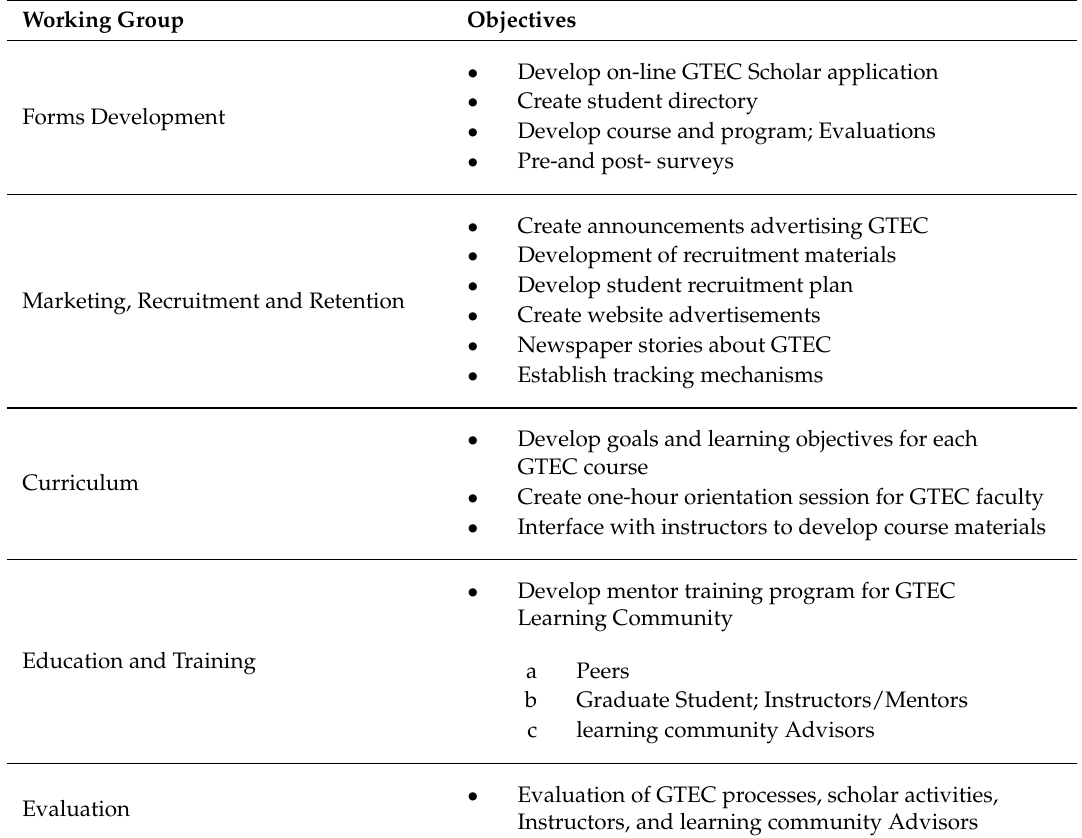
Table 2. GTEC Working